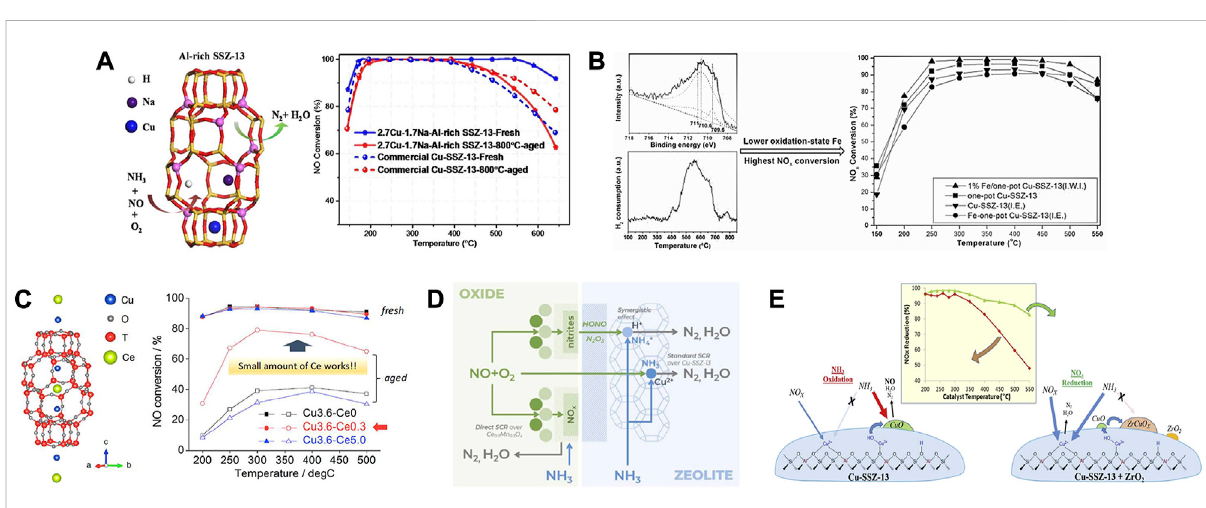
FIGURE 6 (A) Effects of Na + ions on the activity and hydrothermal stability of Cu-SSZ-13 catalysts. Reproduced with permission Zhao et al. (2017), Copyright2017,ElsevierPublishers. (B) EffectsofFeimpregnationontheactivityofCu-SSZ-13catalyst.ReproducedwithpermissionChenM.Y.etal. (2021), Copyright 2016, Royal Society of Chemistry. (C) Location of the Cu and Ce cations in Cu-SSZ-13 and the effect of Ce loading on the SCR performance and hydrothermal stability. Reproduced with permission Usui et al. (2018), Copyright 2018, American Chemical Society. (D) Schematicdiagram ofSCR mechanism of MnO x -CeO 2 -Cu-SSZ-13compositecatalyst. Reproducedwith permission Andana etal. (2022),Copyright 2022, Elsevier Publishers. (E) Enhanced high-temperature SCR activity and schematic diagram of the highly dispersed ZrO 2 modi fi ed